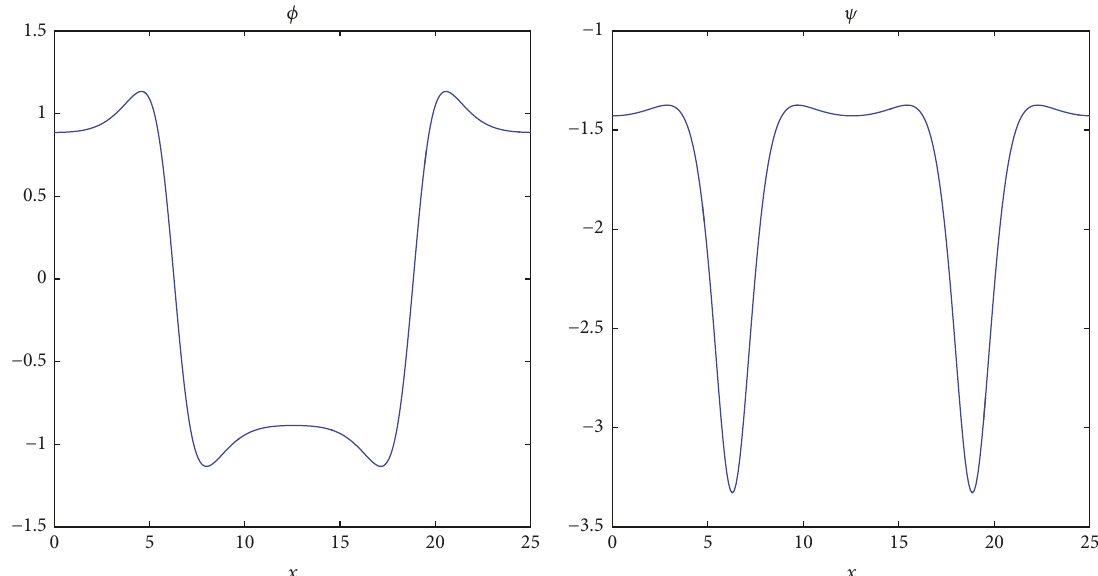
00.20.40.60.811.2